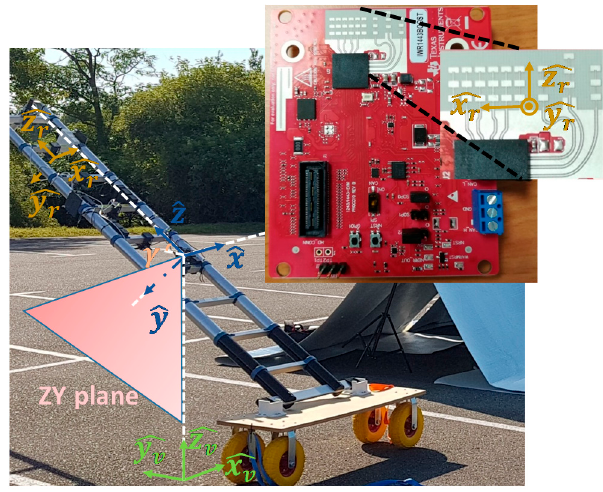
Figure A1. Coordinate system representation.